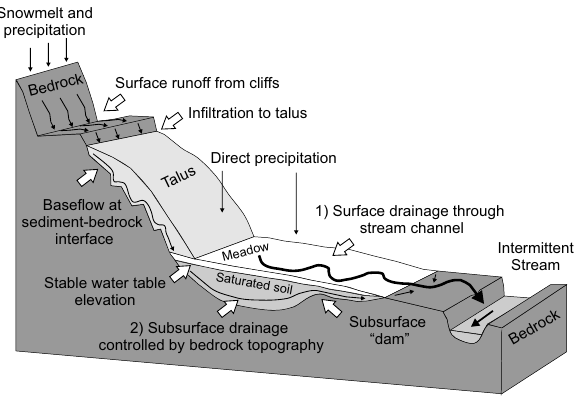
Fig. 11. Schematic diagram showing the internal structure and groundwater and surface water flow pathways in the talus-meadow